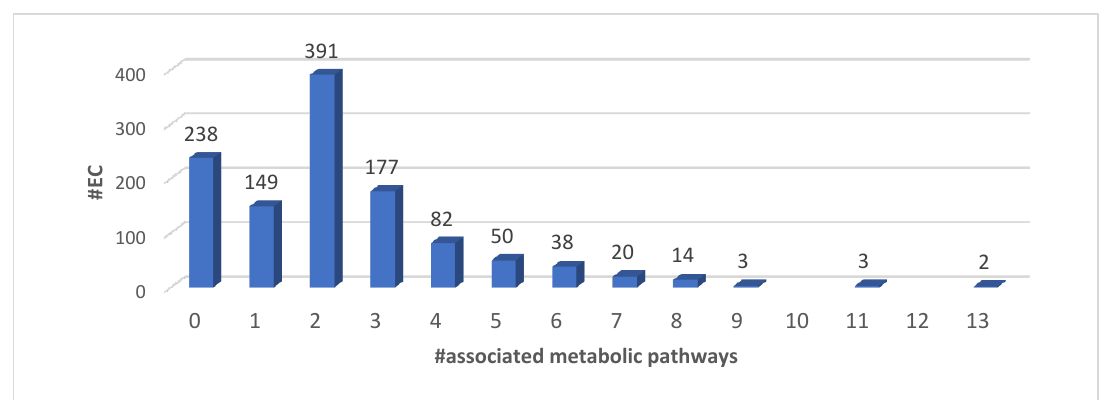
Figure 1. Distribution of functional activities (four-digit EC numbers) as a function of KEGG metabolic pathways.